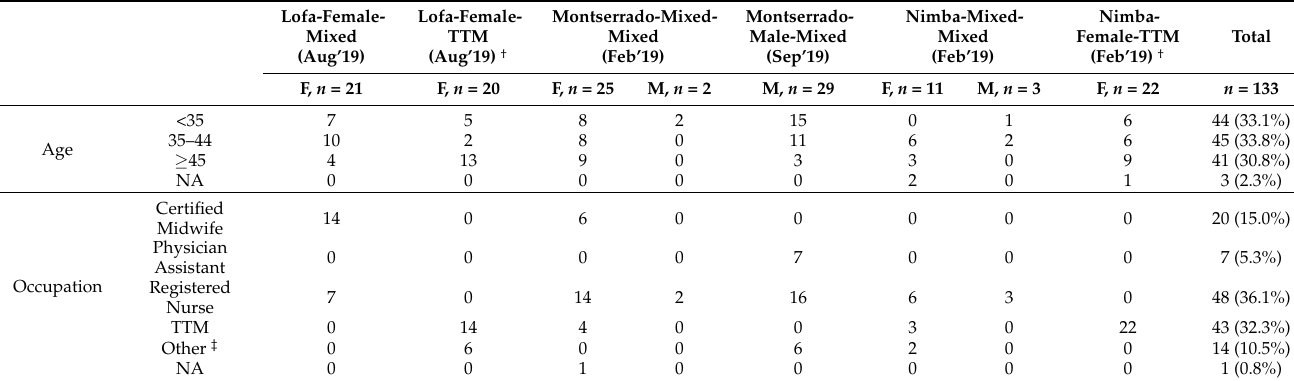
Table 1. Socio-demographics of trainee